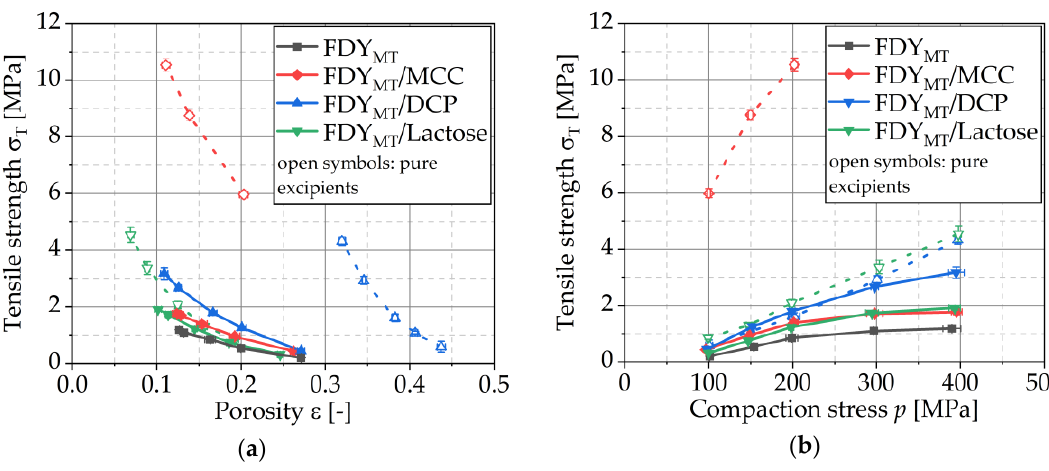
Figure 9. Compactibility ( a ) and tabletability profiles ( b ) of FDY MT and FDY MT mixed with MCC, DCP and lactose as well as of pure excipients. Symbols represent means and error bars standard deviation; n = 10.